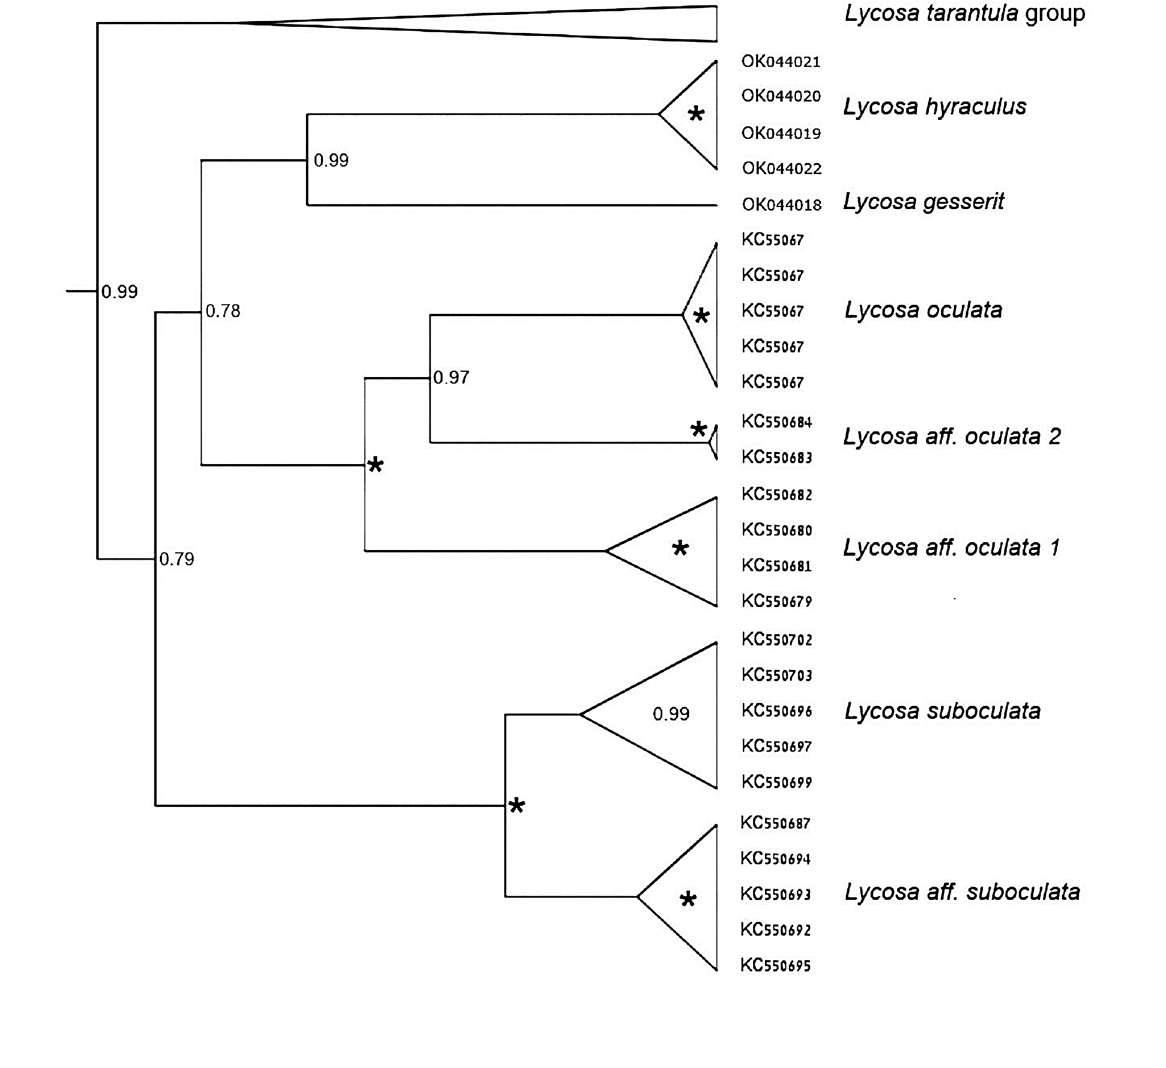
Fig. 24. Bayesian phylogeny cladogram, showing the topology of the oculata group. Posterior probabilities of 1 marked by asterisk. Specimens used for this phylogeny detailed in Table